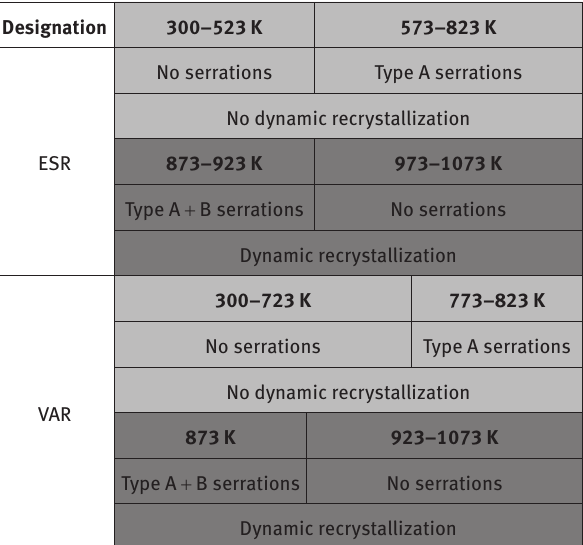
Table 2: DSA and DRX regions of ESR and VAR